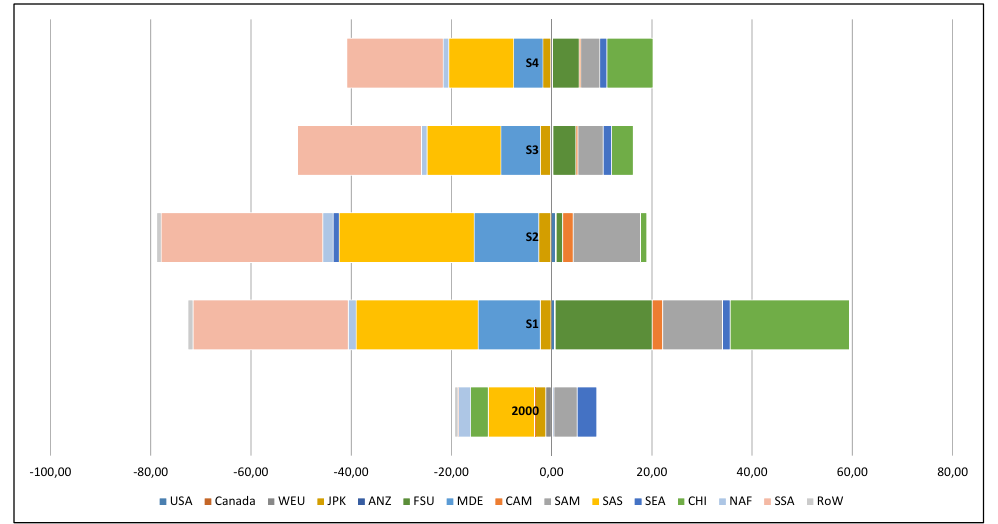
Figure 5. Net virtual water import by Eastern Europe (EEU) (billion m 3 /year), specified by world region. Positive values represent net virtual water import to EEU from other regions; negative values represent net virtual water export from EEU to other regions.